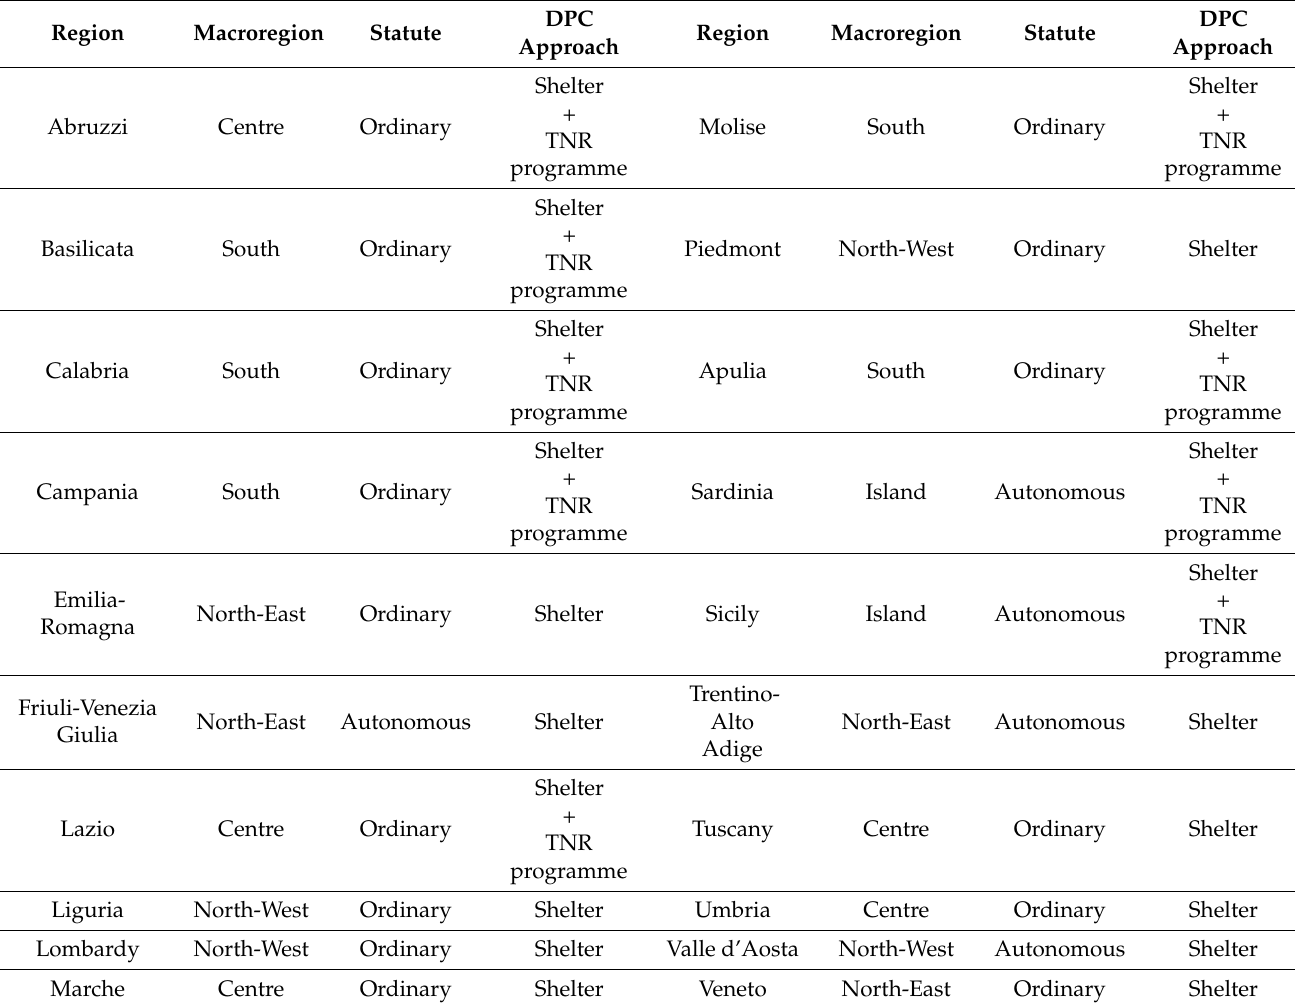
Table 2. Different approaches of the Italian regions to dog population control